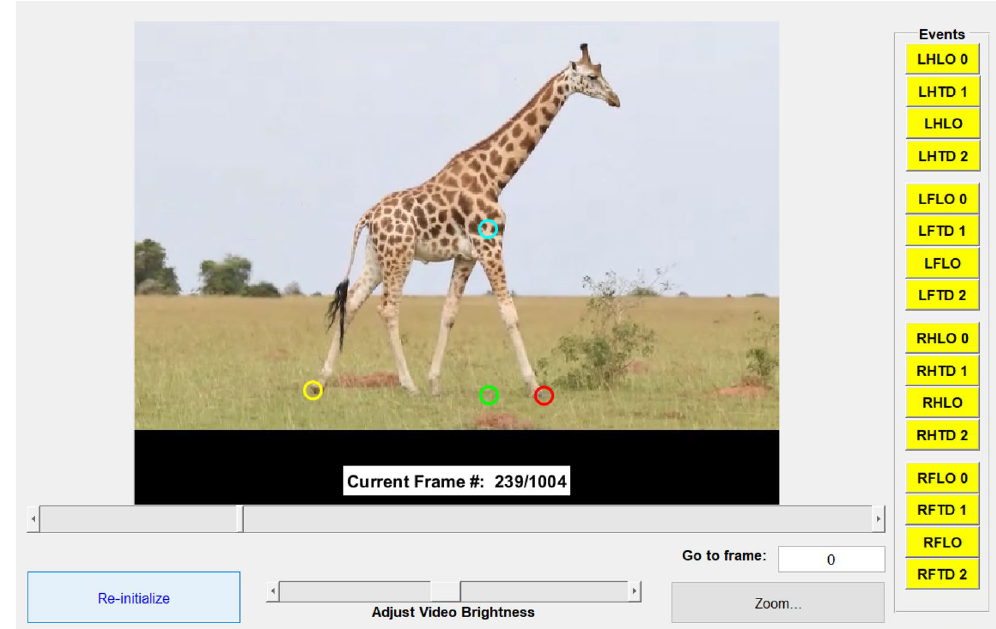
Figure 2. Screenshot of GaitKeeper graphical user interface used to digitize spatiotemporal limb kinematics. The timings of limb liftoff (LO) and touchdown (TD) events were recorded by selecting the corresponding video frame number for each event. We digitized two LO and TD events for each limb (i.e., LH = left hindlimb; LF = left forelimb; RH = right hindlimb; RF = right forelimb). These data were used to quantify stride duration, limb phase, mean number of supporting limbs, and duty factors. Stride length (i.e., distance between yellow and red points) and shoulder height (i.e., distance between blue and green points) were quantified in pixels and used to calculate relative stride length. Stride duration and relative stride length were used to calculate relative